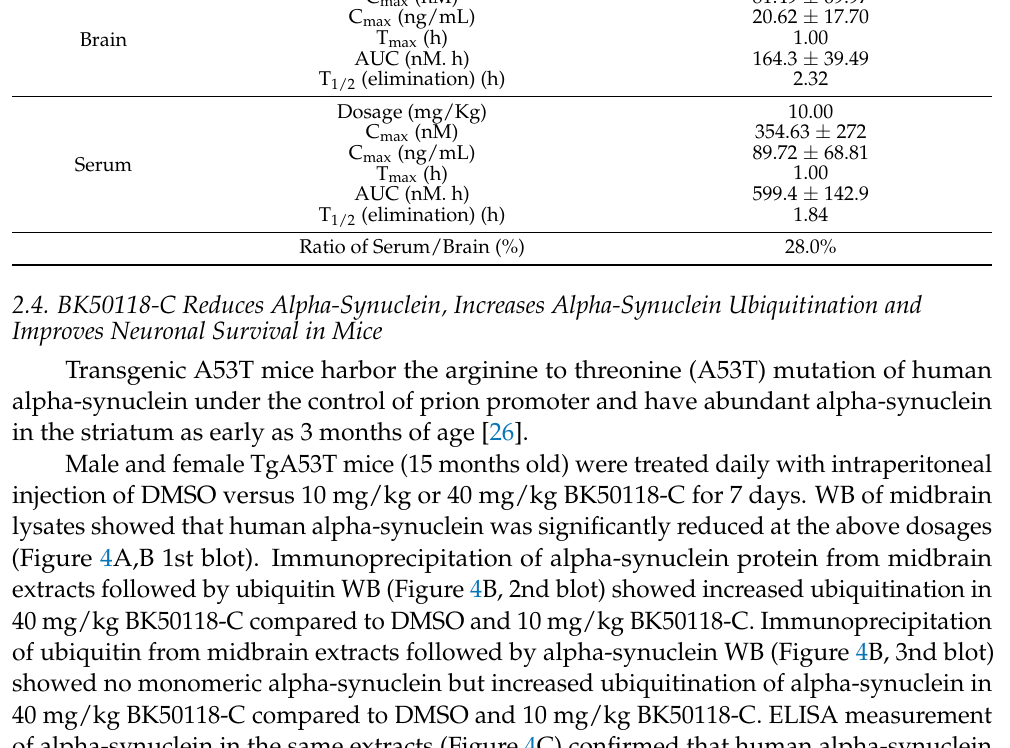
Table 1. Pharmacological parameters of BK50118-C measured in wild type mice (C57B6) injected with 10 mg/kg of deuterated BK50118-C and tissues were collected over 12 h after injection. Dosage (mg/kg, BK50118-C